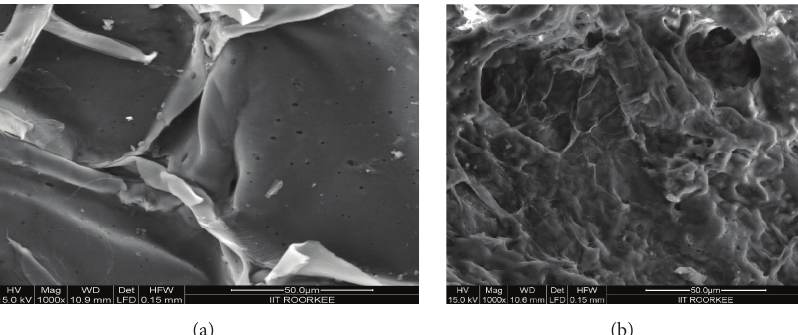
Figure 1: (a) SEM image of Fe treated rice husk before adsorption. (b) SEM image of Fe treated rice husk after simultaneous adsorption of Cr(VI) and phenol.